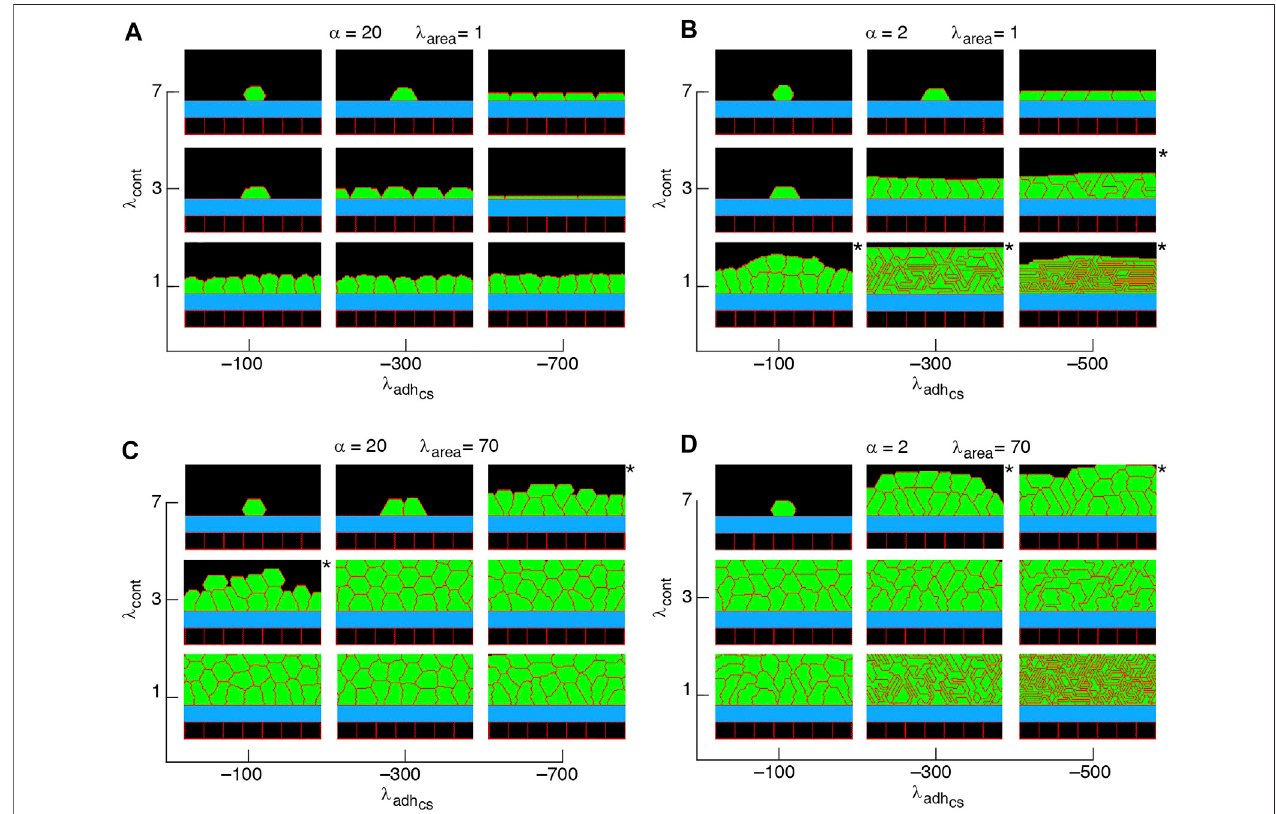
FIGURE 7 | Phase diagram of collective cell morphologies when orientation of cell proliferation is along the major axis of the cells (A – D) . α (cid:1) λ adh growing multilayers. See Supplementary Movie S8 .